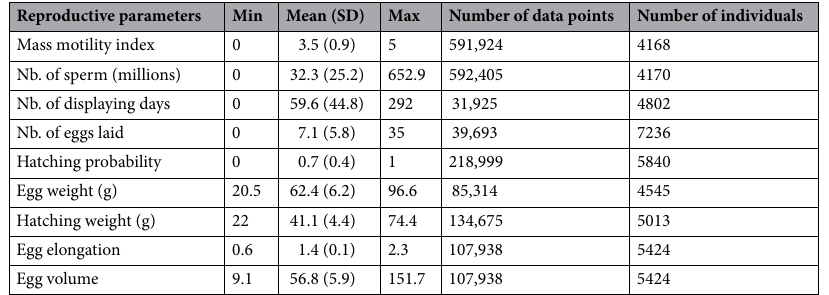
Table 2. Descriptive statistics for each reproductive parameter analyzed within the ECWP’s captive population of houbara. Min . minimum, Max . maximum, SD standard